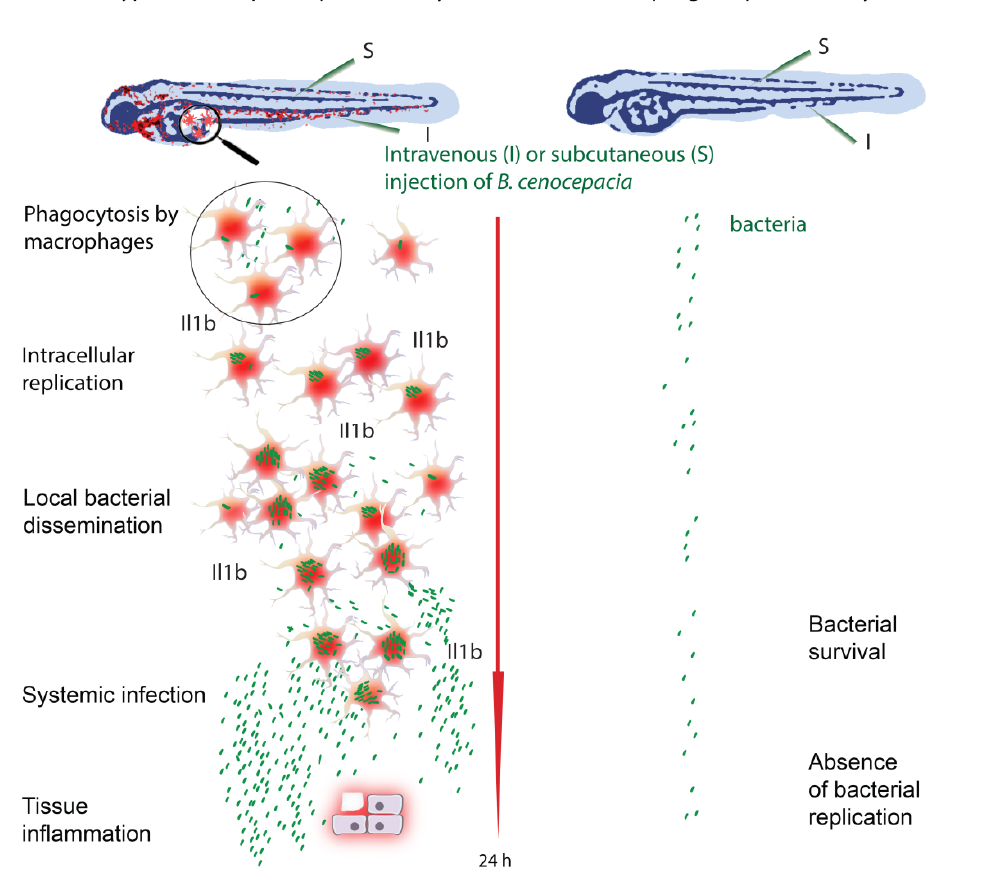
FIGURE 1: B. cenocepacia requires macrophages for efficient replication and the induction of acute pro- inflammatory disease. Zebrafish larvae are highly sensitive to infection with B. cenocepacia K56-2. Injec- tion of a small inoculum (5 - 50 colony forming units) causes rapid pro- inflammatory fatal disease that requires the presence of macrophages, but not neutrophils. Macrophages are important for the ob- served increase in il1b ex- pression. In the absence of macrophages, either using a Pu.1 morpholino knock- down approach or chemical ablation based on the Met- ronidazole / Nitroreductase system, B. cenocepacia K56- 2 is unable to proliferate as in wildtype. This phenome- non was observed when the bacteria were injected intravenously and subcuta-